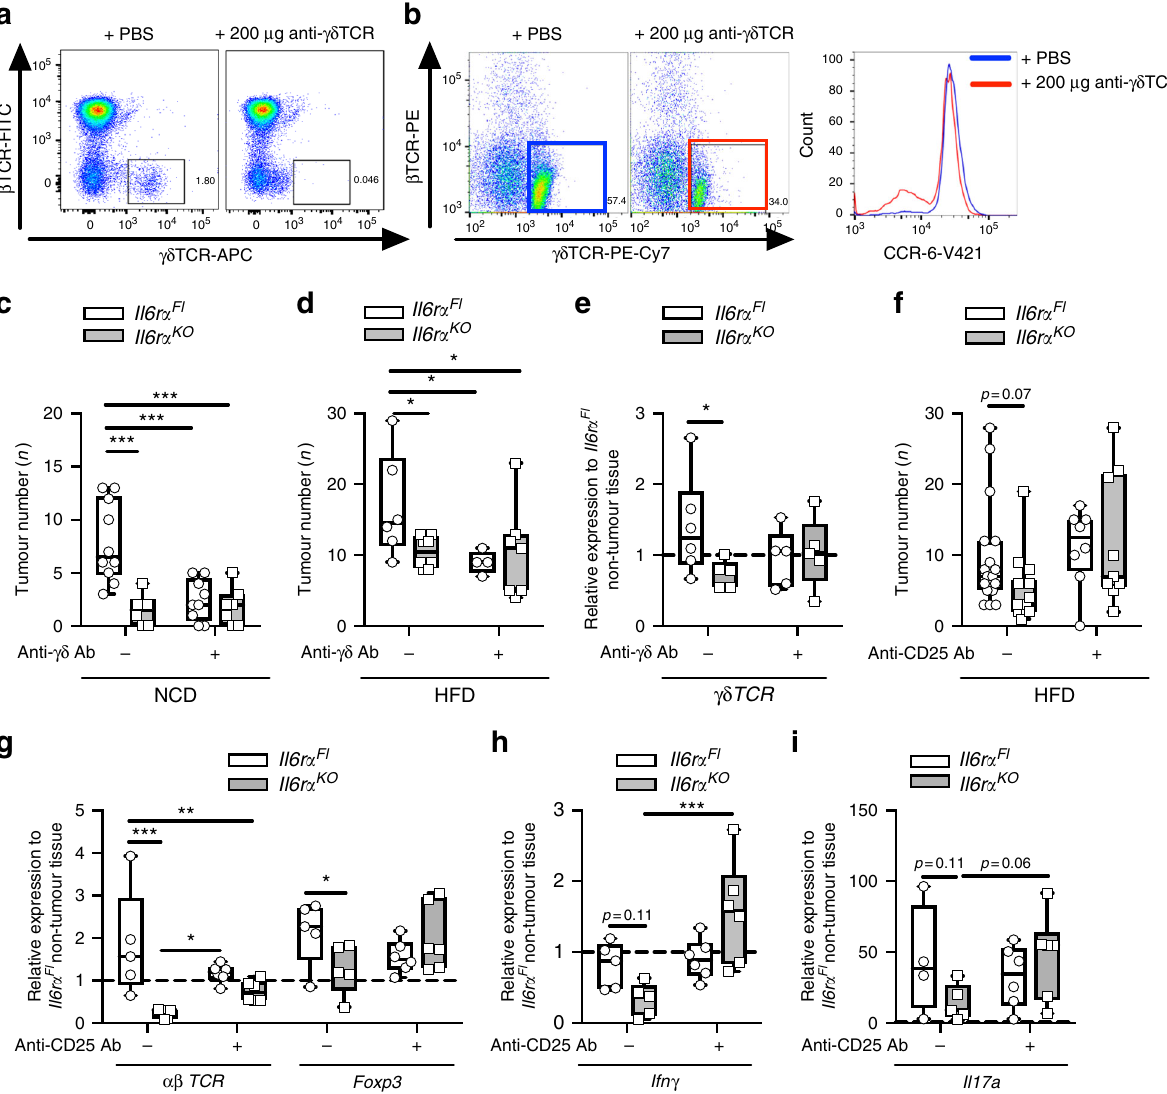
Fig. 7 Recruitment of CCR-6 + T cells in CAC. a Representative FACS plots of β TCR and γδ TCR expression in blood of NCD-fed Il6r α Fl mice at day 5 injected either with PBS or 200 μ g anti- γδ antibody at day 3 of the 1.5% AOM/DSS protocol. b Representative FACS plots of β TCR and γδ TCR expression in lymphocytes of colons derived from 10-week-old NCD fed Il6r α Fl mice at day 13 injected either with PBS or 200 μ g anti- γδ antibody at day 3 of the 1.5% AOM/DSS protocol and histogram of mean fl uorescent intensity of CCR-6 expression in γδ TCR + lymphocytes from PBS (blue) or 200 μ g anti- γδ antibody (red) injected mice. Tumour number of 17-week-old NCD c ( n = 6 – 11) and HFD-fed d ( n = 4 – 8) of Il6r α Fl and Il6r α KO mice counted at day 62 injected with either PBS or 200 μ g anti- γδ antibody at day 3 of the 1.5% AOM/DSS protocol. e qPCR analysis of γδ TCR gene expression in tumours of 17-week-old NCD- fed Il6r α Fl and Il6r α KO mice ( n = 6) at day 62 injected with either PBS or 200 μ g anti- γδ antibody at day 3 of the 1.5% AOM/DSS protocol, results are presented relative to Il6r α Fl non-tumour tissue. f Tumour number of 17-week-old HFD-fed Il6r α Fl and Il6r α KO mice ( n = 8 – 17) counted at 62 days injected with either PBS or 1 mg anti-CD25 antibody at day 3 of the 1.5% AOM/DSS protocol. g – i qPCR analysis of indicated gene expression in tumours of 17- week-old HFD-fed Il6r α Fl and Il6r α KO mice ( n = 6 – 7) at day 62 injected with either PBS or 1 mg anti-CD25 antibody at day 3 of the 1.5% AOM/DSS protocol, results are presented relative to Il6r Fl non-tumour tissue. AOM, azoxymethane; DSS, dextran sodium sulphate; NCD, normal chow diet; HFD, high-fat diet; CAC, colitis-associated colorectal cancer; Ab, Antibody. centre line: median; box limits: 1st and 3rd quartiles; whisker: maximum to minimum, * p ≤ 0.05, ** p ≤ 0.01 and *** p ≤ 0.001 two-way ANOVA followed by Fisher LSD c –